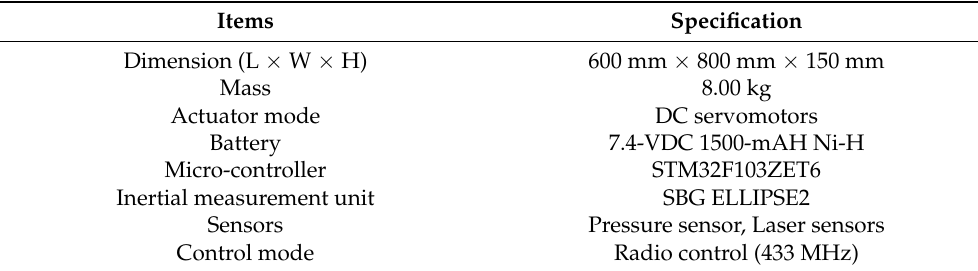
Figure 2. The control system hardware structure. ( A ) Electronic composition. ( B ) Picture of the control system. Table 1. The technical specifications of the robotic manta.